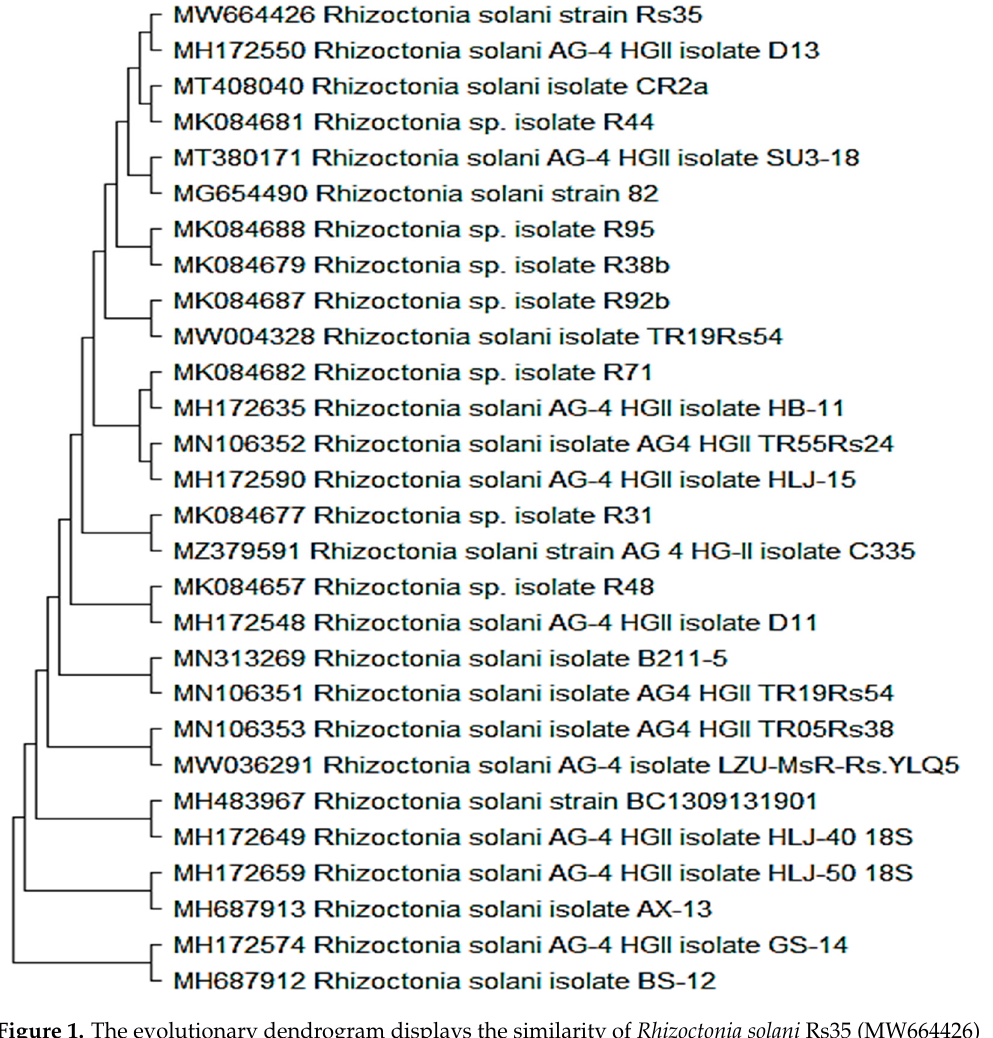
Figure 1. The evolutionary dendrogram displays the similarity of Rhizoctonia solani Rs35 (MW664426) to other R. solani nucleotide ITS sequences.